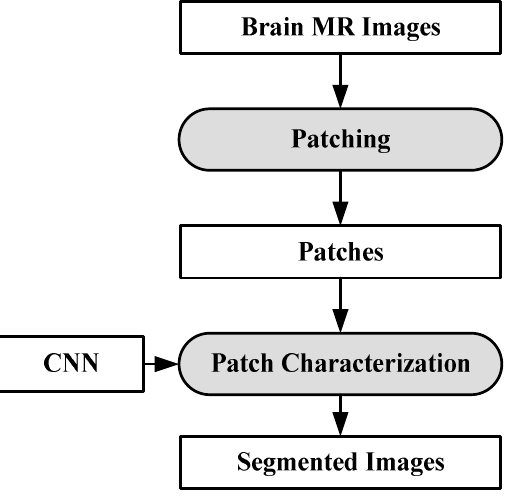
Figure 13. Process model for segmentation [102].